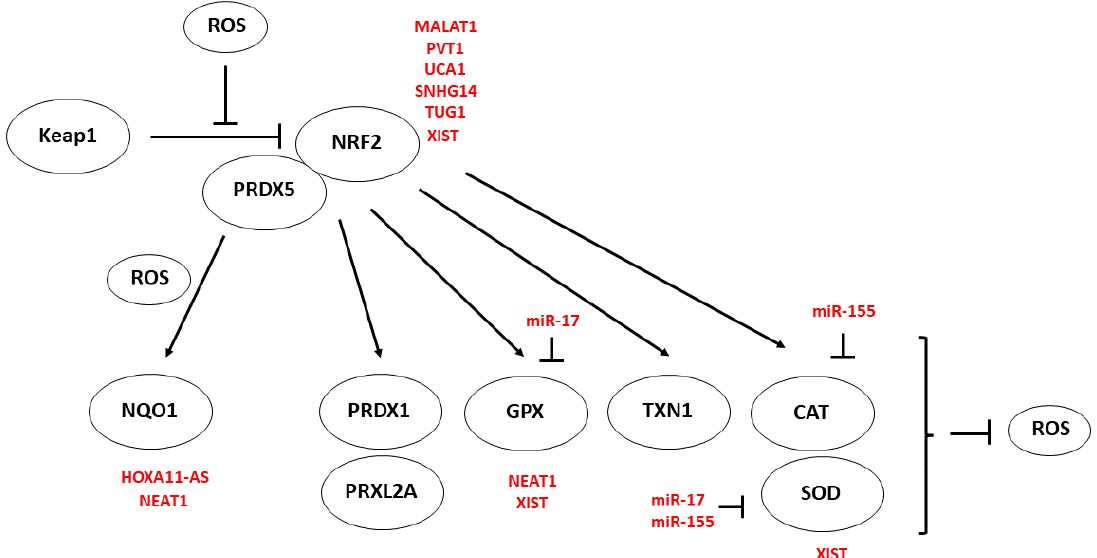
Figure 2. Noncoding RNA and antioxidant activity. ROS levels depend on the tumor’s antioxidant capacity to counterbalance the increased production of ROS. This capacity largely depends on the transcription factor nuclear factor (erythroid-derived 2)–related factor-2 (NRF2). ROS activates tyrosine kinases which dissociate the NRF2 from its inhibitor, the kelch-like ECH-associated protein 1 (Keap1). This dissociation allows the nuclear import of NRF2, activating antioxidant cytoprotective genes, peroxiredoxin-1 (PRDX1), peroxiredoxin-like 2A (PRXL2A), glutathione peroxidases (GPX), thioredoxin-1 (TXN1), and superoxide dismutase (SOD). In addition, NRF2 in ROS-stimulated cancer cells interacts with peroxiredoxin 5 (PRDX5), promoting the expression of NAD(P)H: quinone oxidoreductase 1 (NQO1). NQO1 acts as a superoxide reductase protecting proteins from proteasomal degradation and regulating mRNA translation. Upregulated noncoding RNAs are in red. Arrowheads reflect activation; hammerheads reflect inhibition.